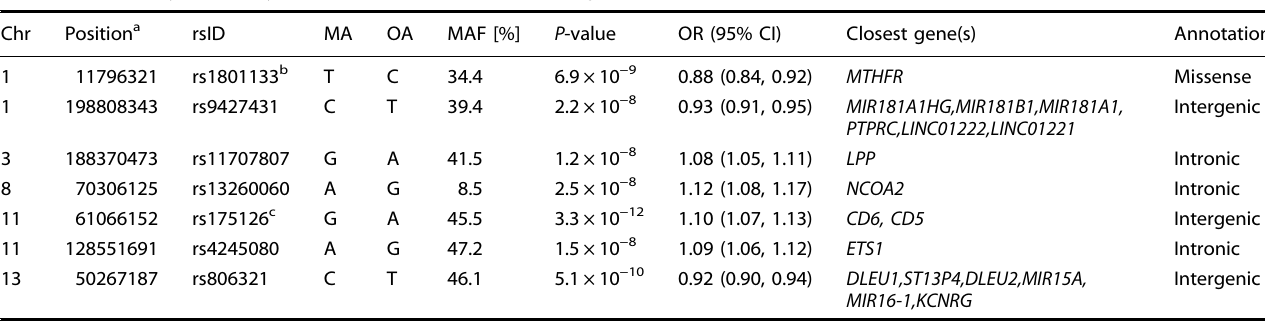
Table 1. Meta-analyses identify seven novel risk variants associating with multiple